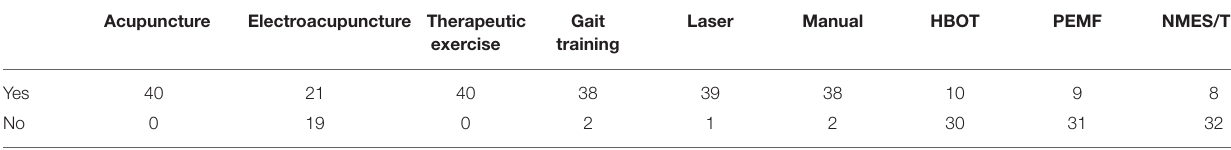
TABLE 2 | Number of patients receiving various rehabilitation treatment modalities. Acupuncture Electroacupuncture Therapeutic